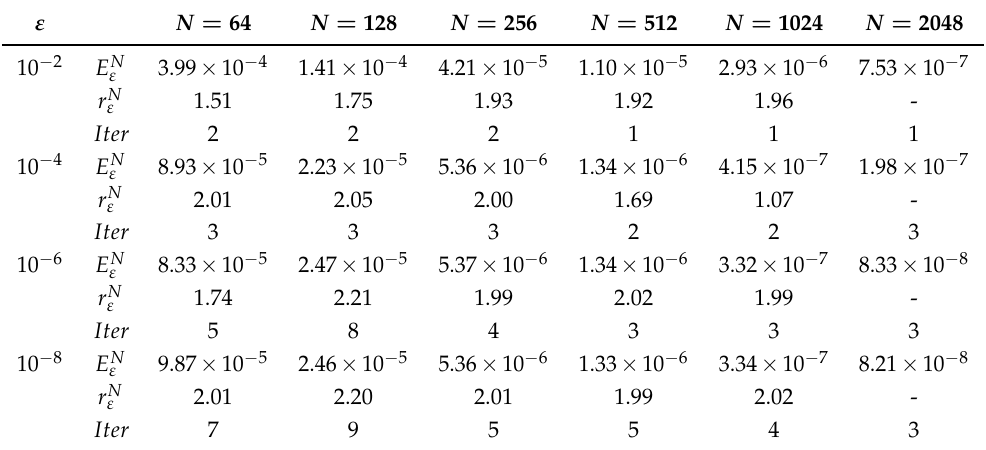
Table 3. Numerical results of our presented adaptive grid method for Example 2.